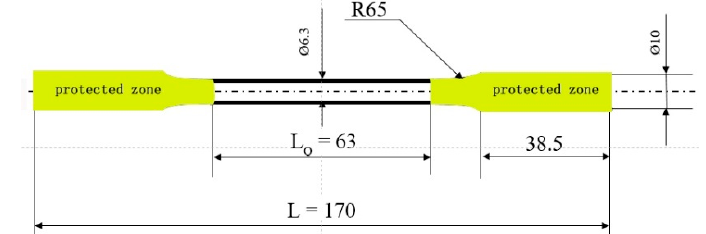
Figure 3. The tensile sample for the corrosion residual strength test.